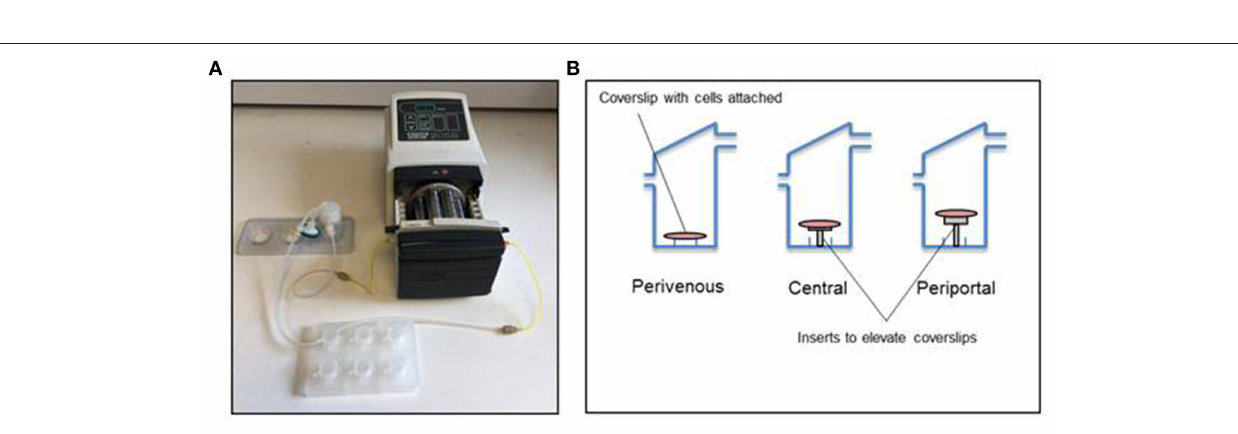
Frontiers in Bioengineering and Biotechnology | www.frontiersin.org